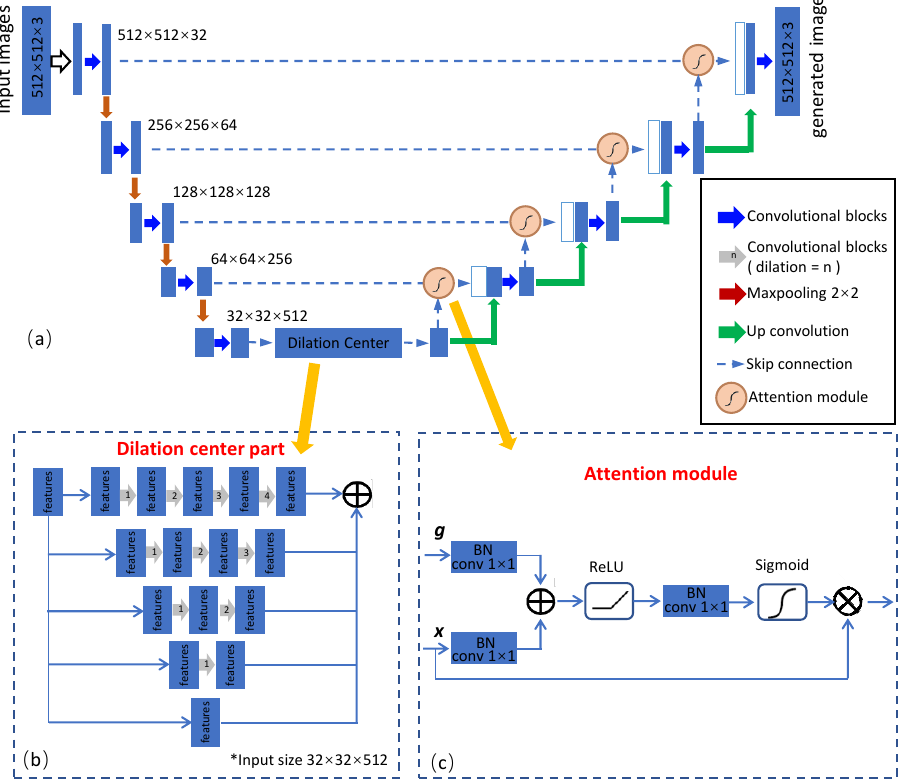
Figure 3. Generator structure of the proposed network. ( a ) encoder–decoder structure with attention modules and a dilation center part; ( b ) detailed information of the dilation center part; ( c ) detailed information of the attention